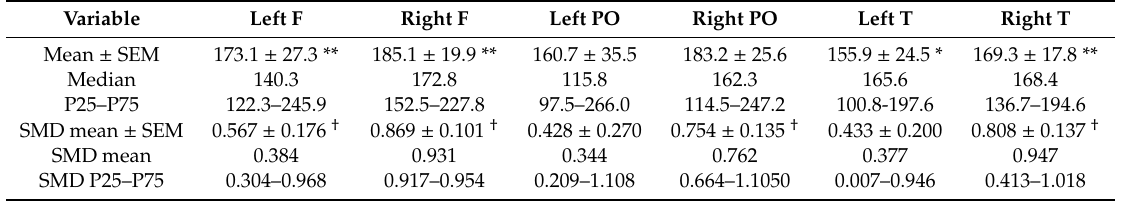
Table A1. Changes in power of delta bands during GS.